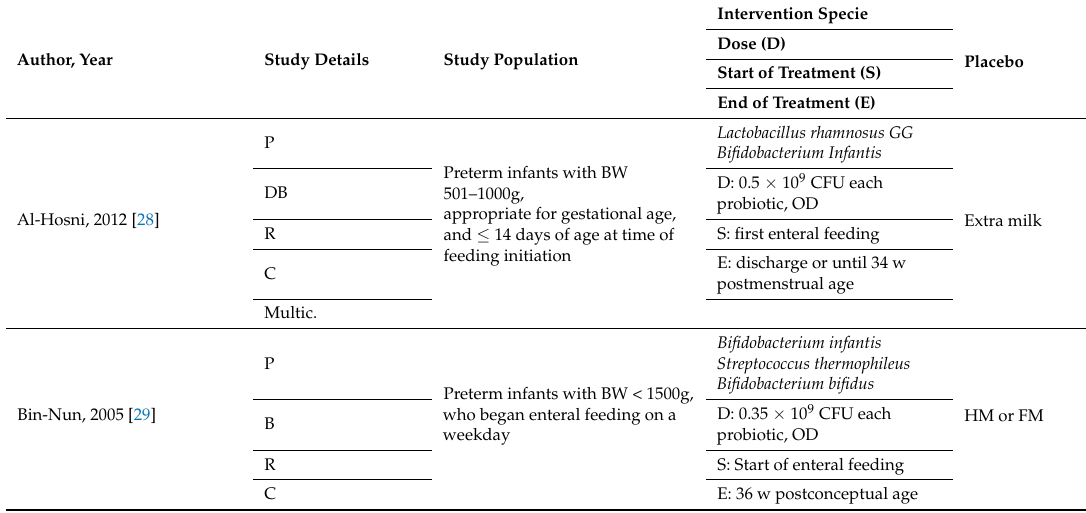
Table 1. Studies included in the systematic